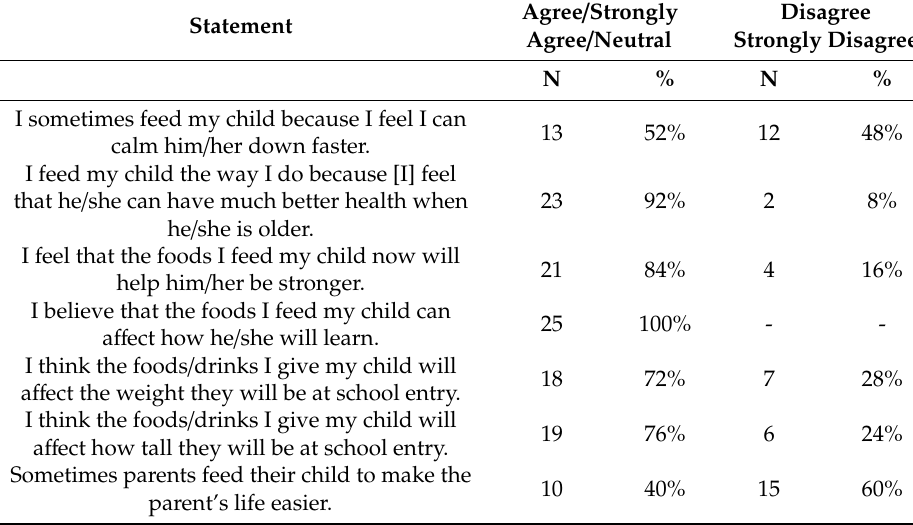
Table 3. Frequency of Participant Agreement to Feeding